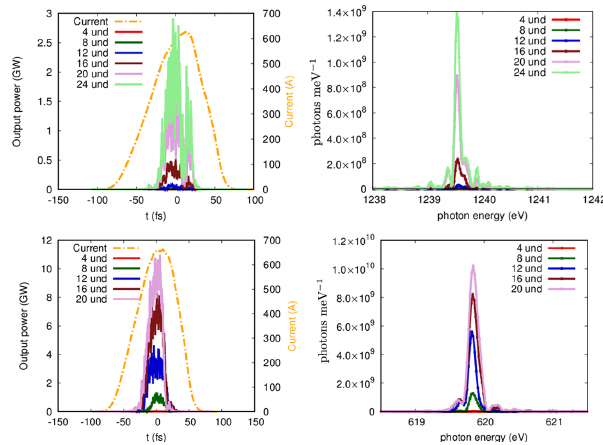
FIG. 9. EEHG with ideal e-beam at 1.2 keV (top) and 620 eV (bottom). Power profiles overlaid with the final current profile (left) and spectra (right) at different positions along the radiating undulators. Note that, for clarity, the current profiles are averaged over the wavelength of the UV laser seeds.